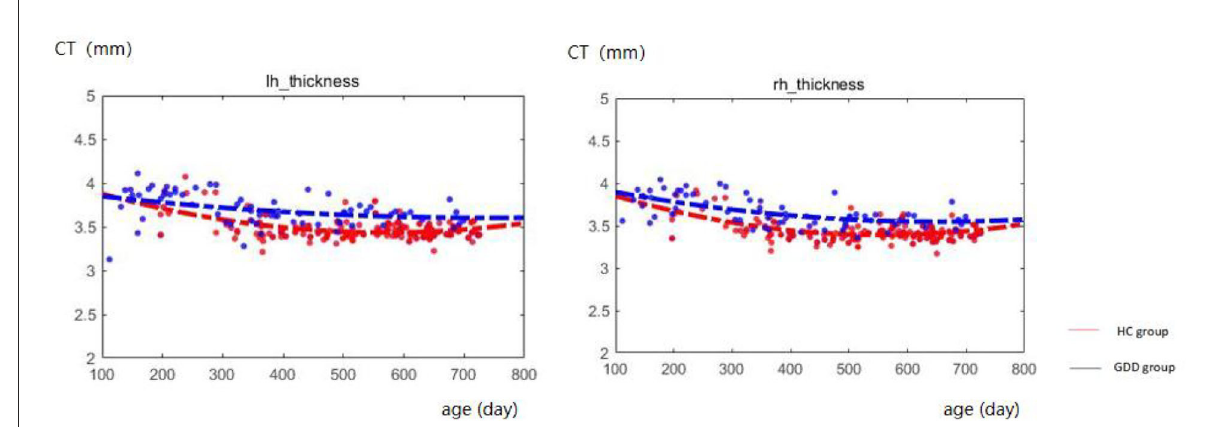
FIGURE1 Hemispherical CT developmental trajectories of the two groups. The red line represents the HC group, and the blue line represents the GDD group (lh, left hemisphere; rh, right hemisphere).